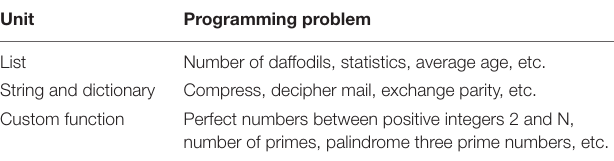
TABLE 1 | Programming issues corresponding to the unit. Unit Programming problem List Number of daffodils, statistics, average age,